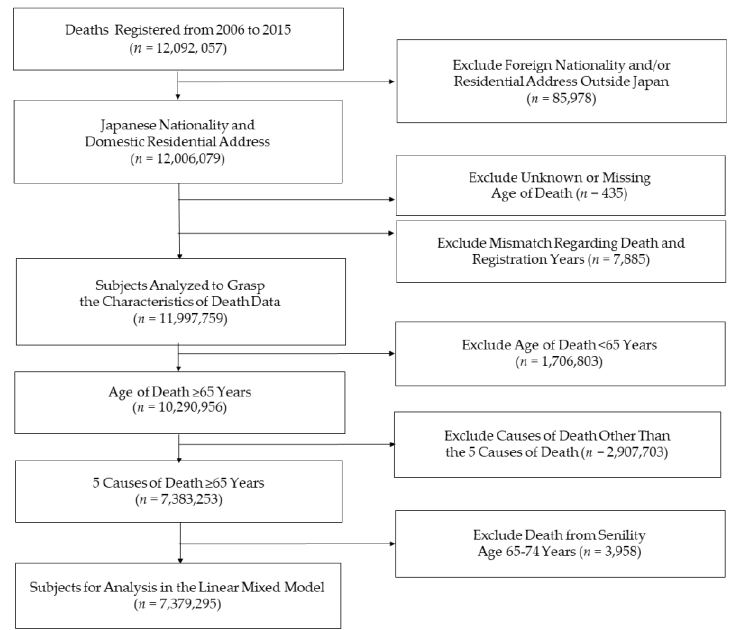
Figure 1. Flow chart of included and excluded participants.